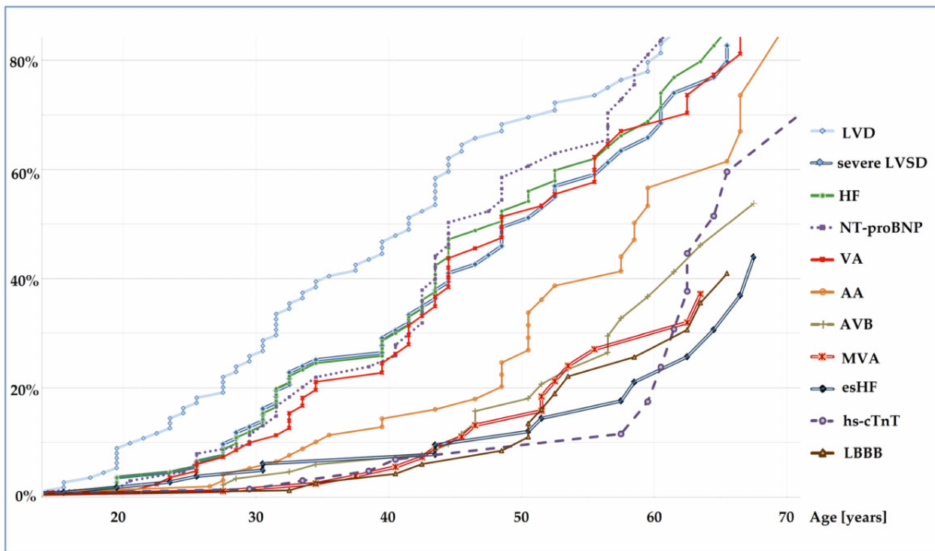
Figure 1. Penetrance of disease indicators estimated by Kaplan–Meier method in the whole study cohort of TTN tv carriers. Legend: AA, atrial arrhythmia; AVB, atrioventricular block; esHF, end- stage heart failure; HF, heart failure; hs-cTnT, high-sensitivity cardiac troponin T concentration >14 ng/L; LBBB, left bundle branch block; LVD, left ventricular dysfunction; severe LVSD, severe left ventricular systolic dysfunction; MVA, malignant ventricular arrhythmia; NT-proBNP, N-terminal pro-B-type natriuretic peptide serum concentration >125 pg/mL; TTN tv, titin truncating variants; VA, ventricular arrhythmia.